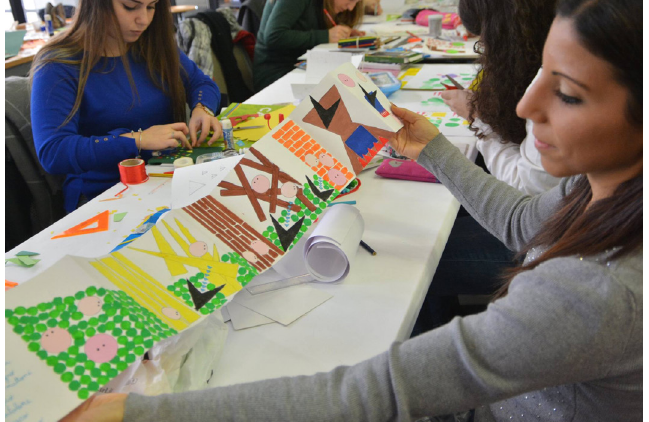
Fig. 1 Astrofavole work